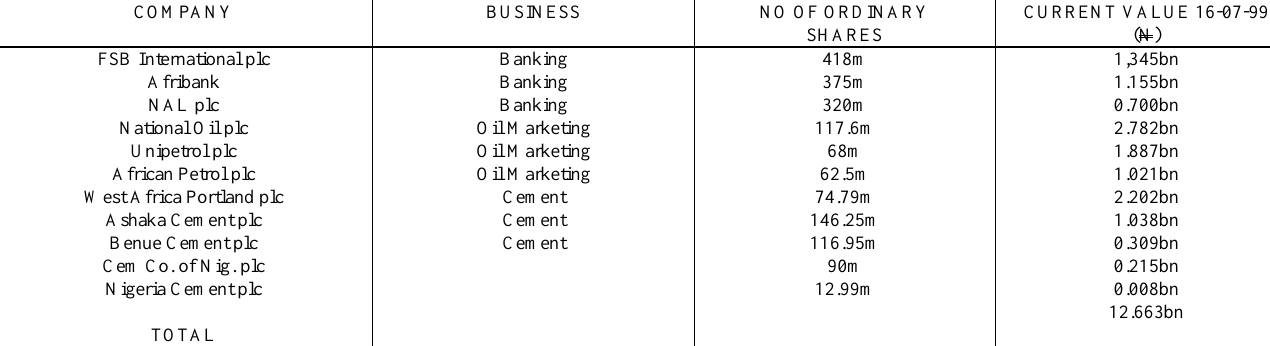
TABLE 1: PROCEEDS OF PRIVATISATION (First Phase) COMPANY BUSINESS